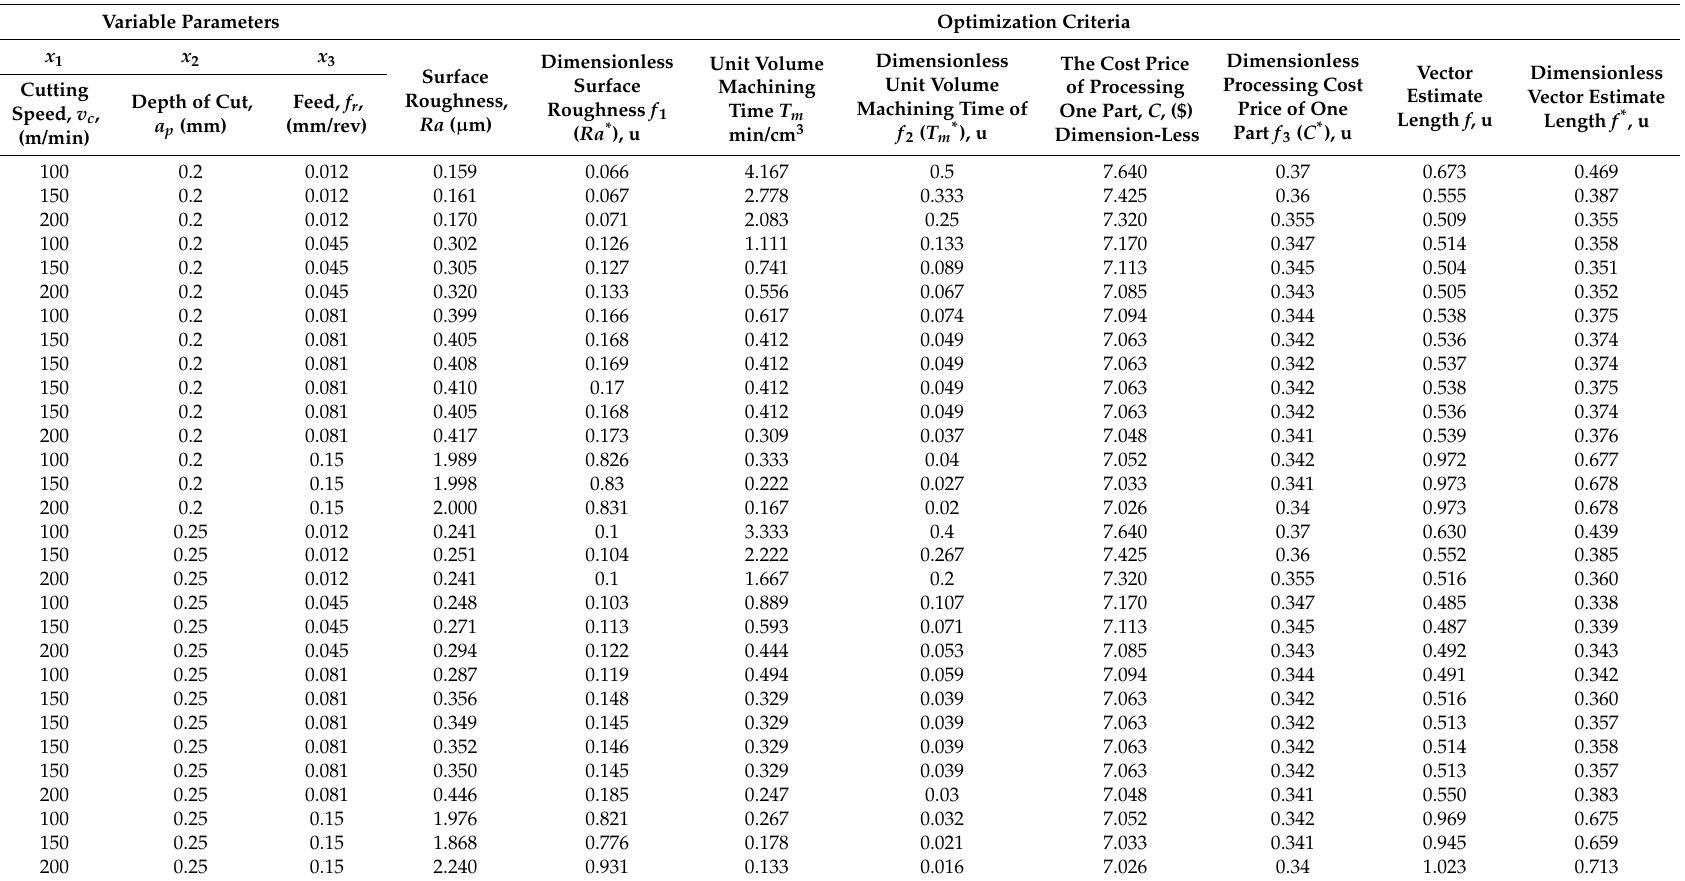
Table 5. A selection of the optimization criteria parameter value set for the variable machining parameters of a workpiece hardened with ET-500. Variable